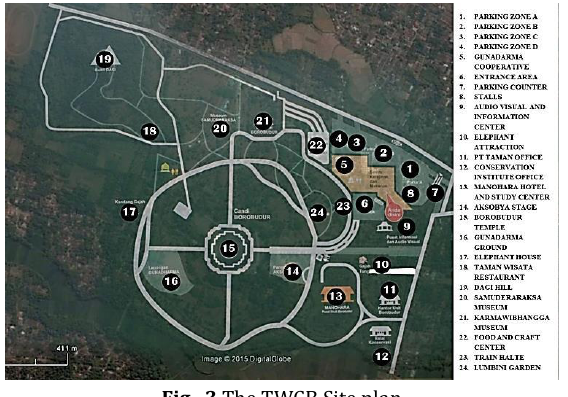
Fig. 3 The TWCB Site